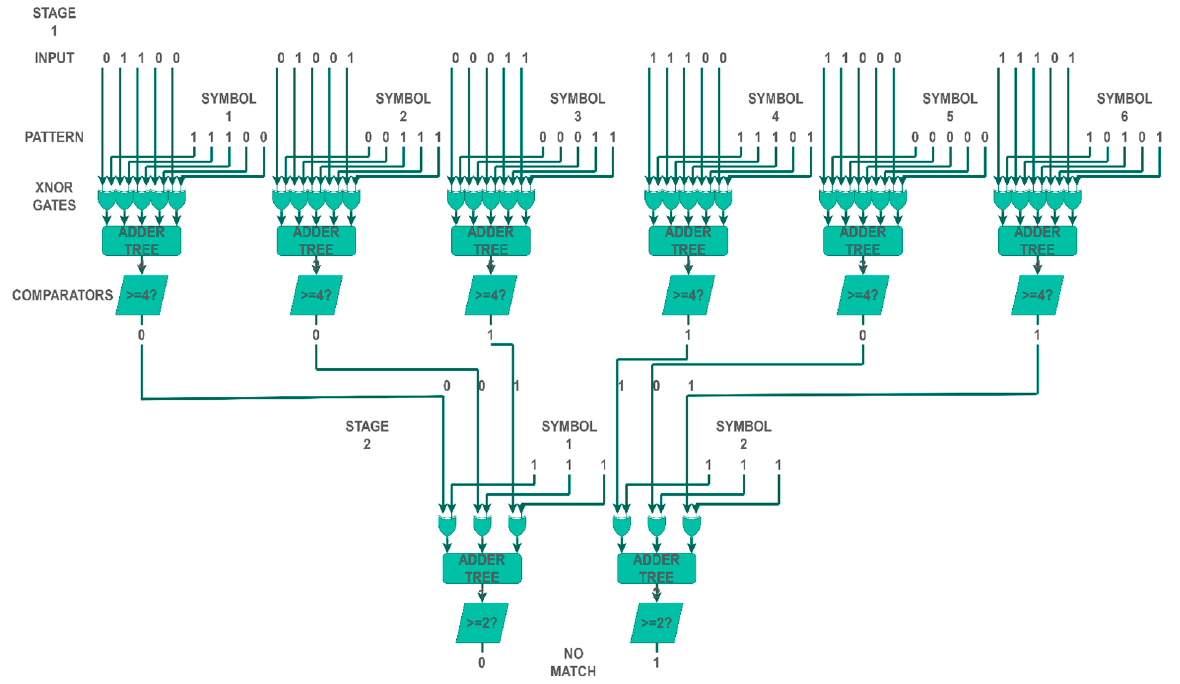
Figure 3. The 2-stage cascaded pattern identifier.